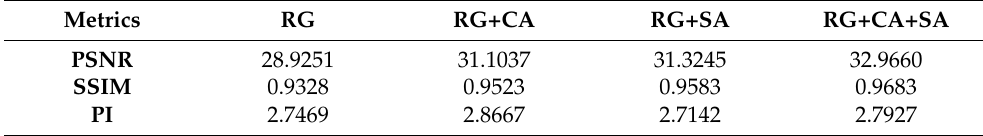
Table 4. Quantitative comparisons with different attention module on RESIDE dataset.